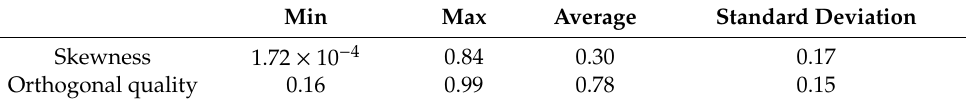
Table 3. The mesh metric information.